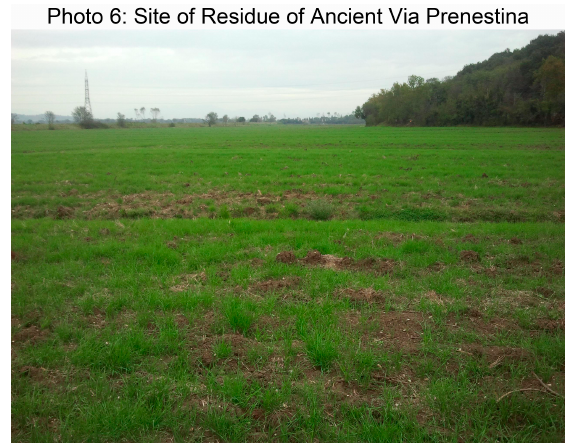
Figure 48. Photo 6 acquired at the location of the residue of the ancient Via Salaria (see Figure 49 for location and direction of photo). Photo acquired on 1 October 2016 at 17:14 CET. On this date, no trace is visible of the archaeological feature on the ground.